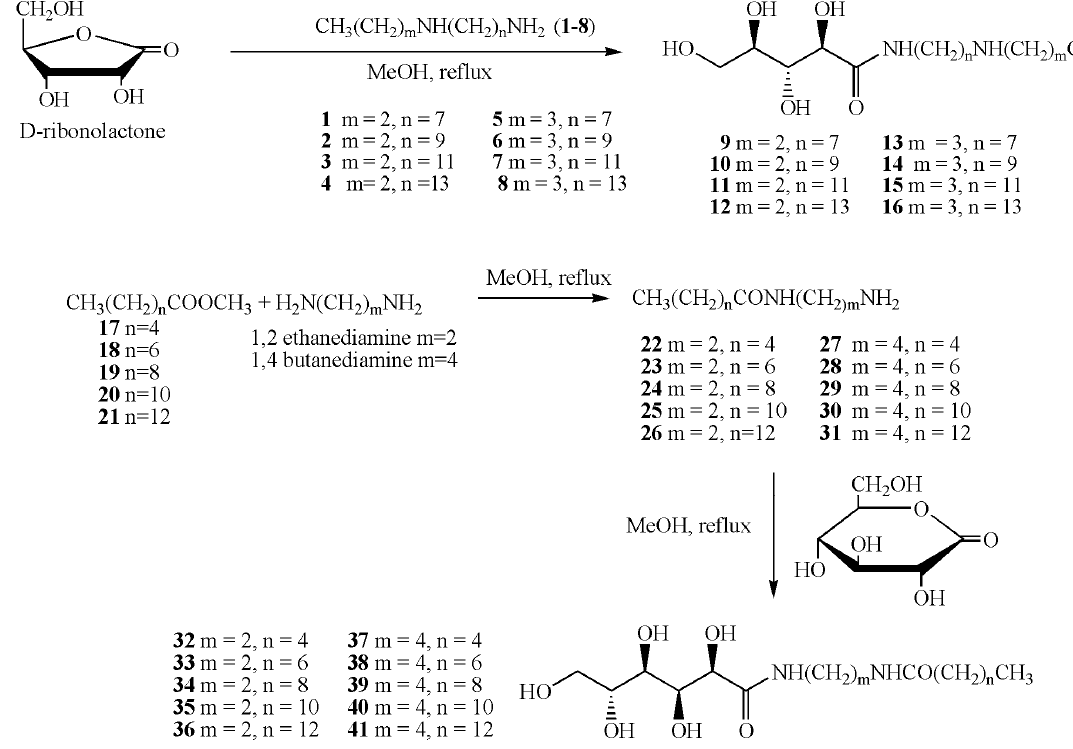
SCHEME 1. Synthesis of potential antileishmanial